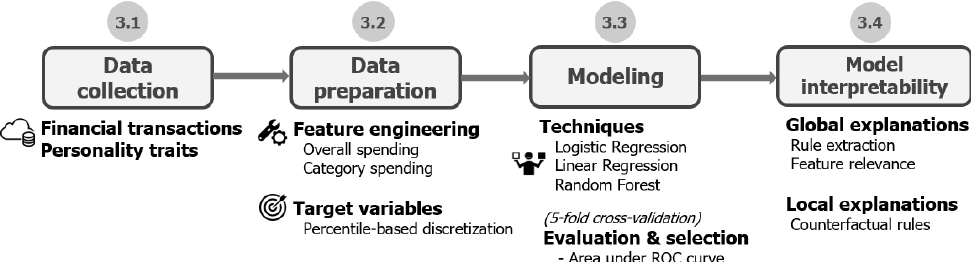
Figure 2. Methodology of the case study to develop models that classify people’s personality from financial transactions (Sections 3.1–3.3) and gain insight into the final models by means of global and local XAI methods (Section